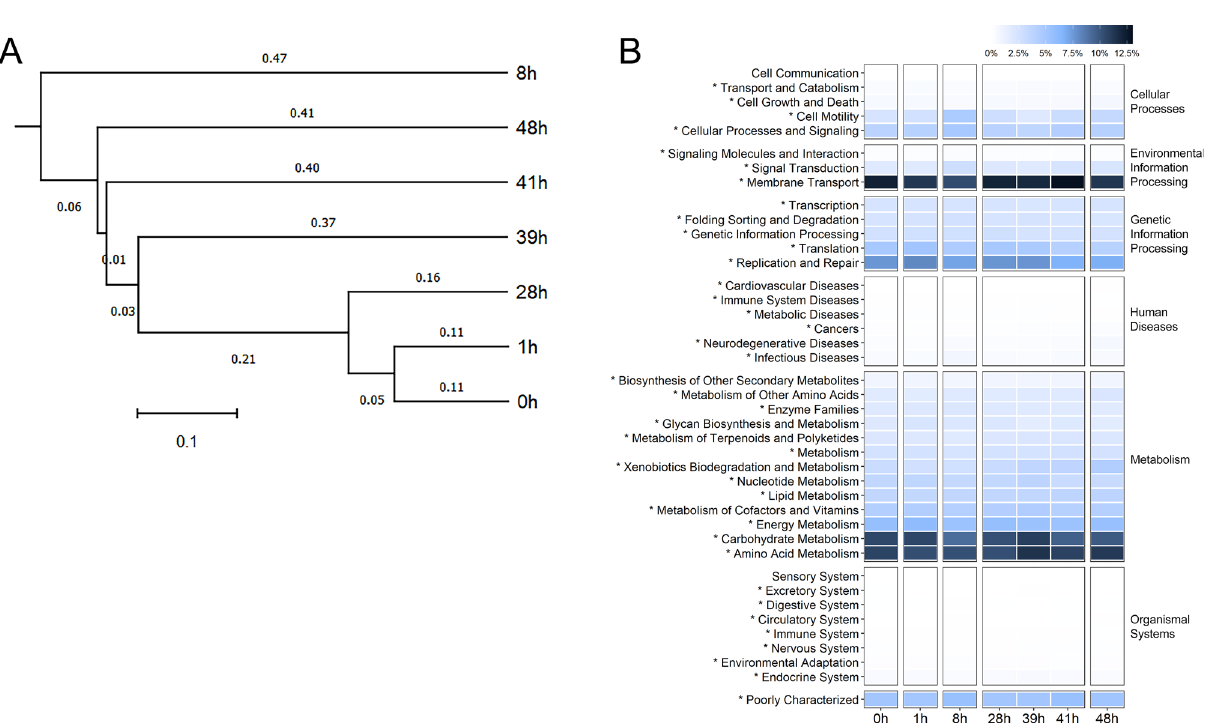
Figure 3. Analyses of bacterial community profiles at genus level OTUs into ( A ) phylogenetic tree and ( B ) microbial functional potentials. In ( B ), * denotes a functional category that had a statistical difference in relative abundance across